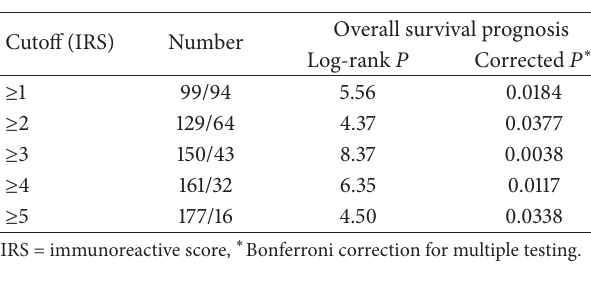
Table 2: Kaplan-Meier overall survival analysis for different immunoreactive scores.